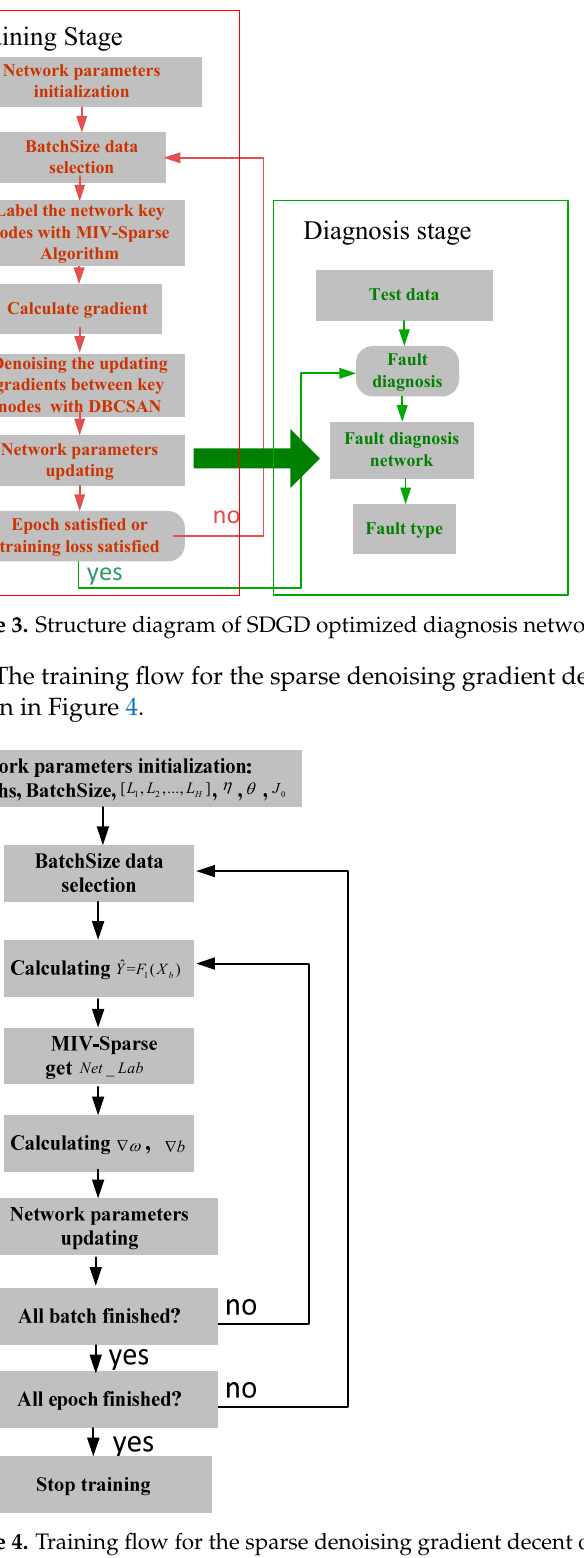
Figure 4. Training flow for the sparse denoising gradient decent optimization algorithm. The process of the sparse denoising gradient descent optimization algorithm is de- scribed as follows.